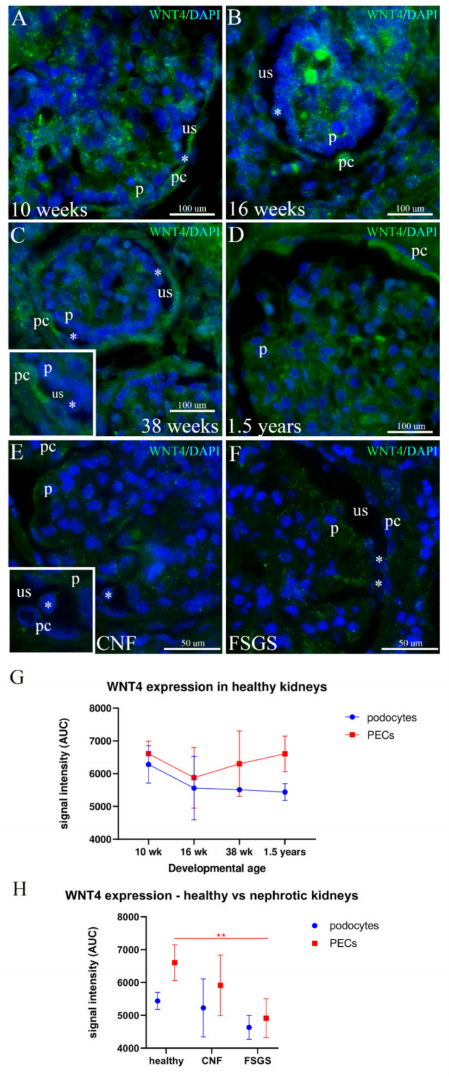
Figure 5. Expression of WNT4 in the developing podocytes and PECs in healthy postnatal kidneys and in CNF and FSGS kidneys; podocytes (p), PECs (pc), urinary space (us). ( A ) 10th developmental week; some podocytes are bridging (asterisk) the developing urinary space. ( B ) 16th developmental week; some podocytes bulge (asterisk) into the urinary space towards PECs. ( C ) 38th developmental week; at several places, podocytes bridge (asterisk) the urinary space. Wider contact between podocytes and parietal cells can be seen in some places (inset). ( D ) Postnatal healthy kidneys; podocyte expression of WNT4 is mild-to-moderate, whereas some PECs retain strong expression. ( E ) CNF kidneys; some cells (asterisk) are bridging the urinary space (inset). ( F ) FSGS kidneys; several cells and their cytoplasmic extensions bridge (asterisks) the urinary space. ( G ) Overall expression pattern of WNT4 in healthy developing kidneys. ( H ) Comparison of the expression pattern between healthy and nephrotic kidneys shows significant differences between PECs of healthy and CNF and FSGS kidneys. Error bars show SD. ** p <